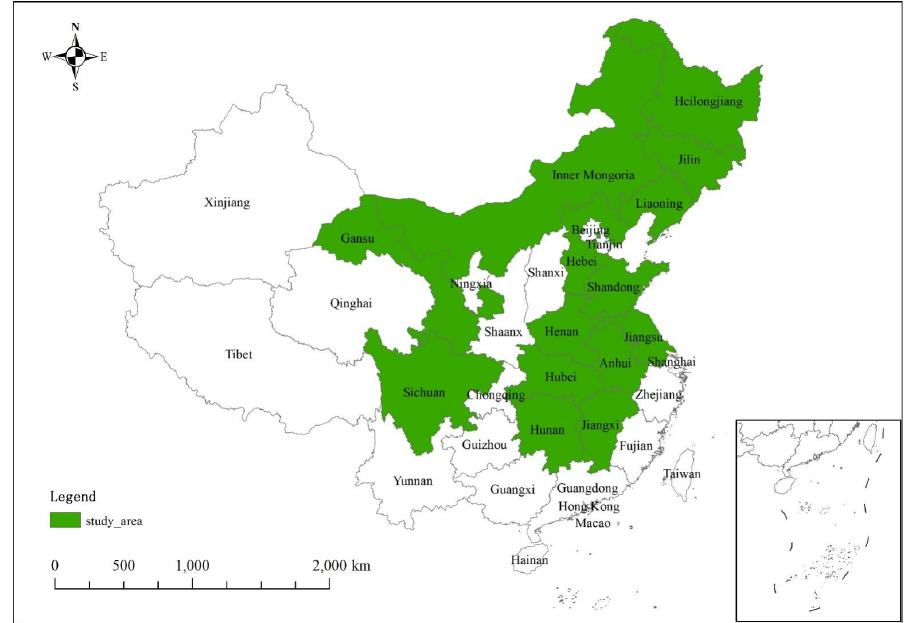
Figure 2. Profile of study areas.